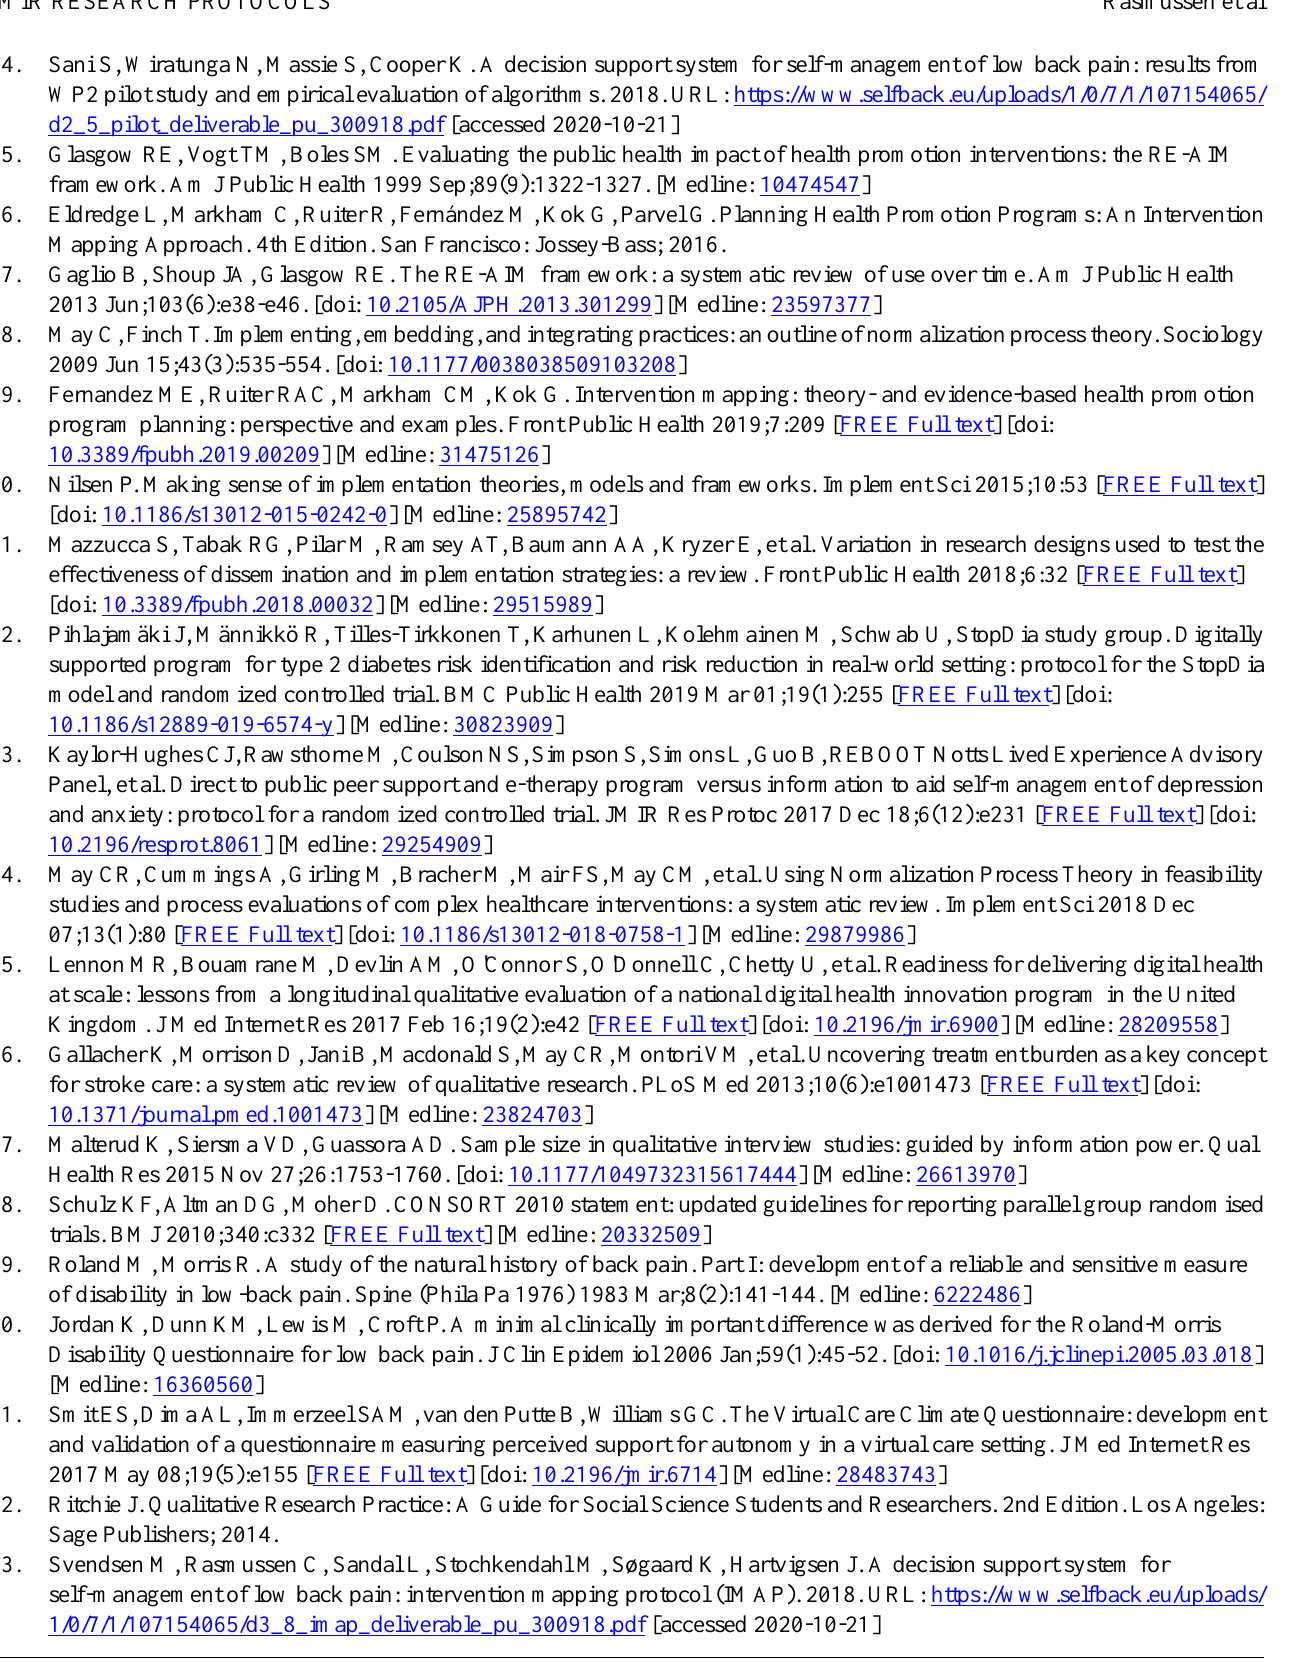
CONSORT: Consolidated Standards on Reporting Trials RCT: randomized controlled